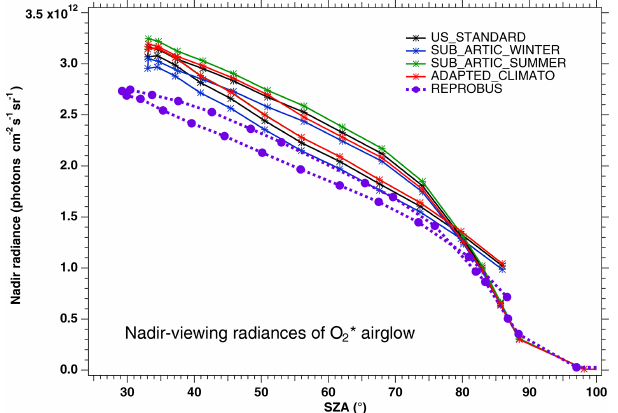
Figure 3. Computed O 2 ∗ radiances in nadir-viewing geometry, de- rived from SCIAMACHY limb radiances, as a function of SZA for orbit 20070101_1256 when the O 2 absorption is computed with var- ious choices of atmospheric models: climatology US_STANDARD (black), SUBARTIC_WINTER (blue), SUBARCTIC_SUMMER (green) and ADAPTED_CLIMATO (red) (see Appendix B for de- tails). There is a slight dependence of the nadir intensity on the choice of atmospheric model. The dashed purple curve (with filled circles) corresponds to the REPROBUS v02